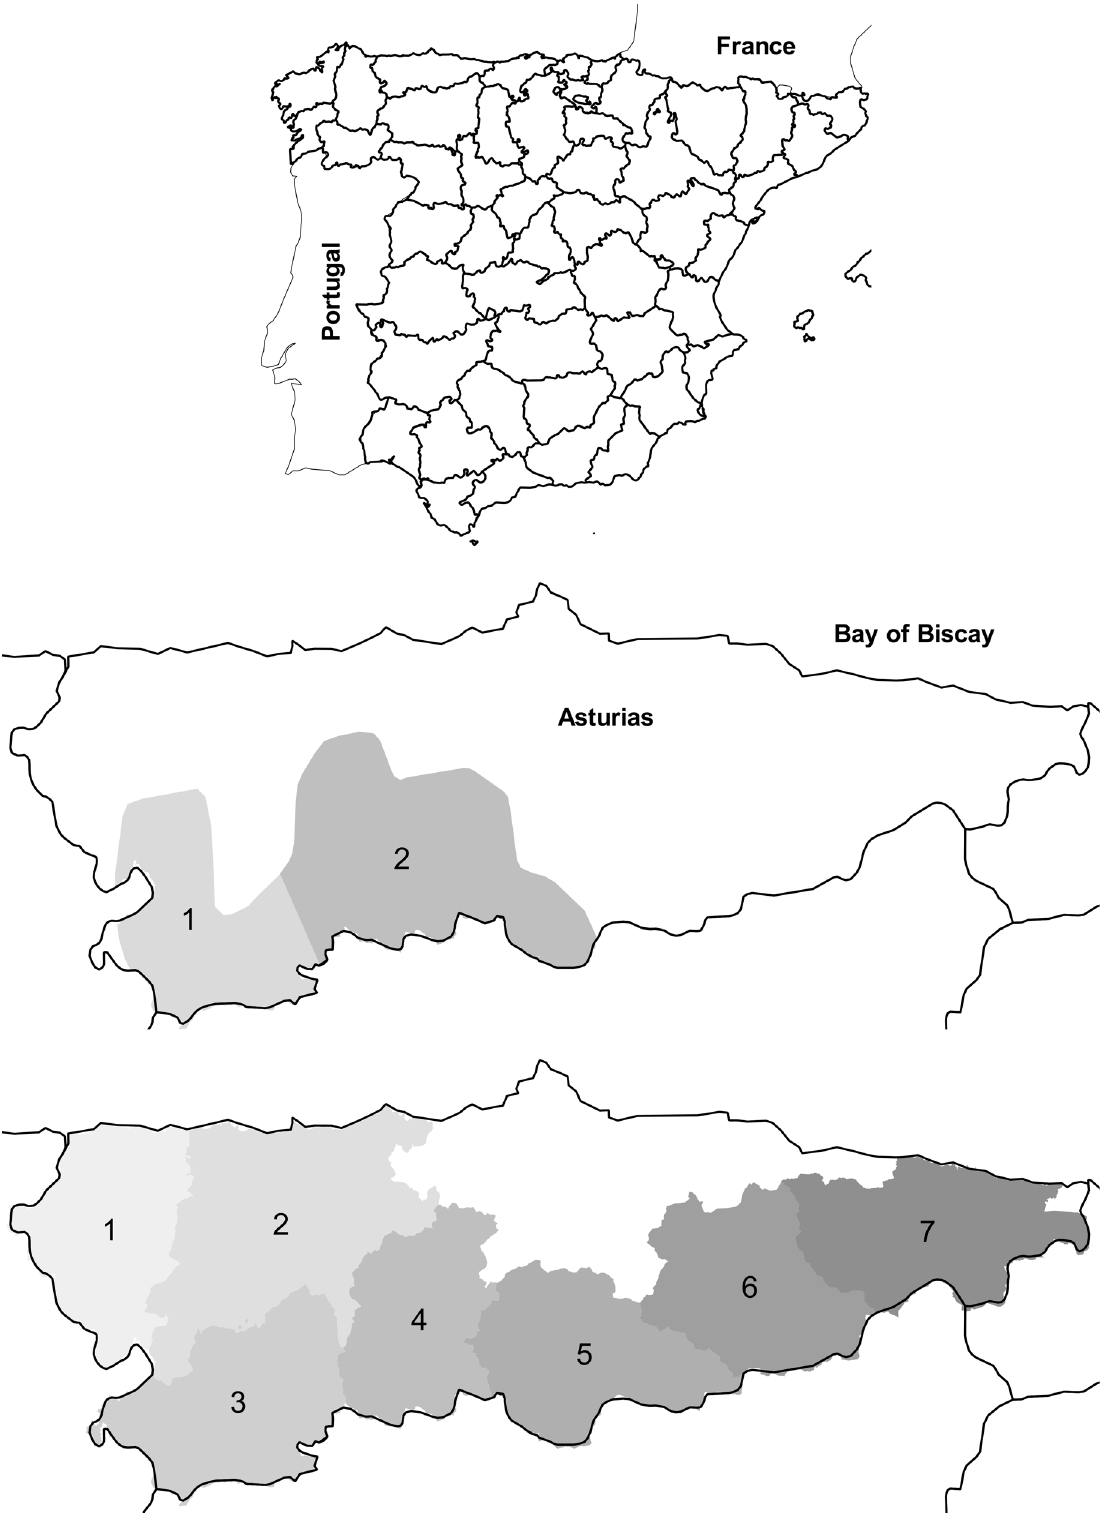
Fig 1. Study area. Top panel: Asturias autonomous region (NW Spain, shaded). Intermediate and bottom panels: brown bear and wolf study zones, respectively, in Asturias. Basemaps made with Natural Earth, public domain map data available at http://www.naturalearthdata.com/.